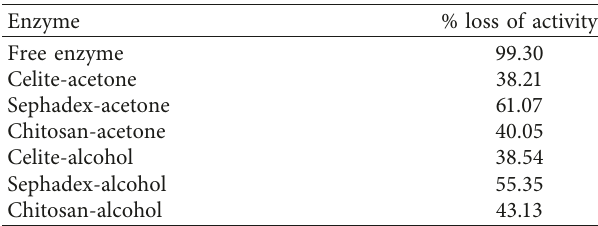
Figure 9: Residual enzyme specific activity (pH 7.0, temperature 1mg/mL). 45 ° C, and [S] (cid:31) Table 5: Percentage loss of enzymatic activity after six successive